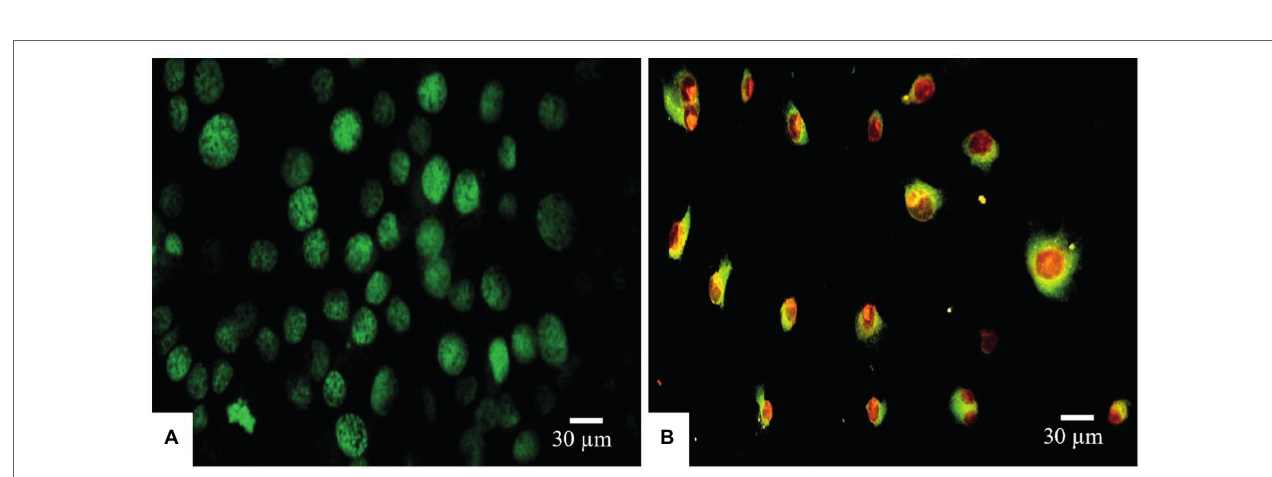
FIGURE 7 | Induced apoptosis progression in HepG2 cells treated with PAAEs. Morphology of cells was subjected in fluorescent microscopy (original magnification, x400). Under the fluorescent microscope, HepG2 cells exhibited apoptotic effects which treated with PAAEs (MW <3 kDa, IC 50 value at 0.54 mg/ml). (A) Untreated cells were stained green. (B) Apoptotic cells were triggered by the